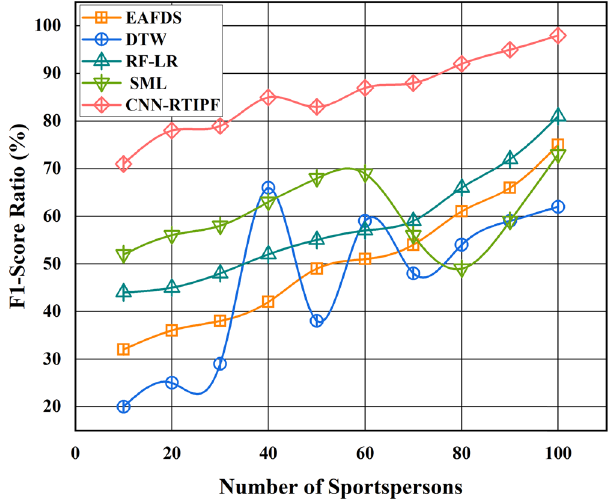
Figure 10: F 1 - Score